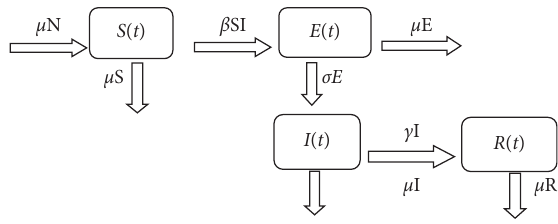
Figure 1: Flowchart of the SEIR Model for measles